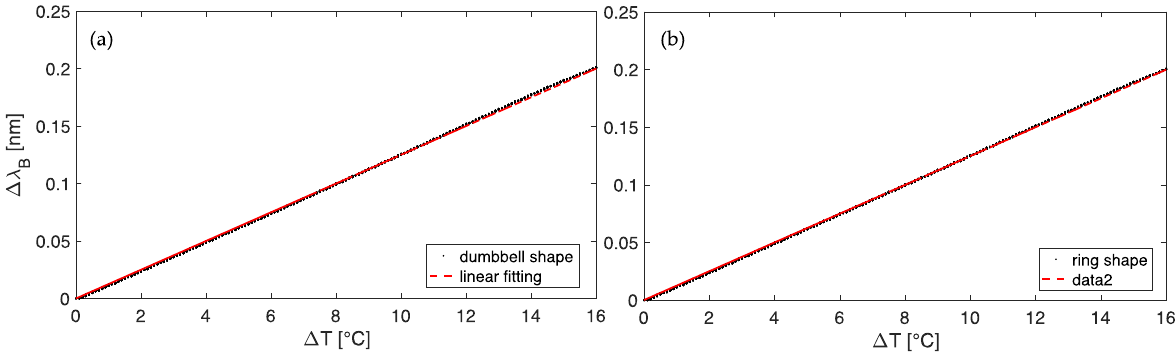
Figure 7. The calibration curve λ B vs. ∆ T of the sensor with a dumbbell shape ( a ) and a ring shape ( b ).